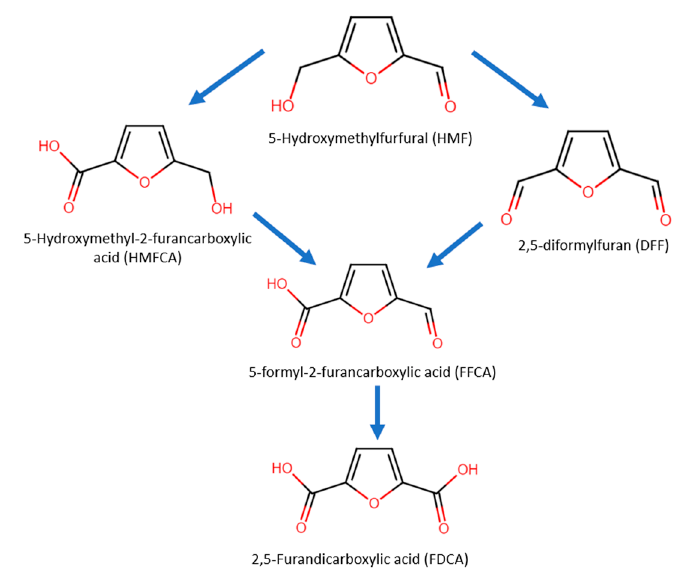
Figure 10. Oxidation pathways and products of 5-HMF.